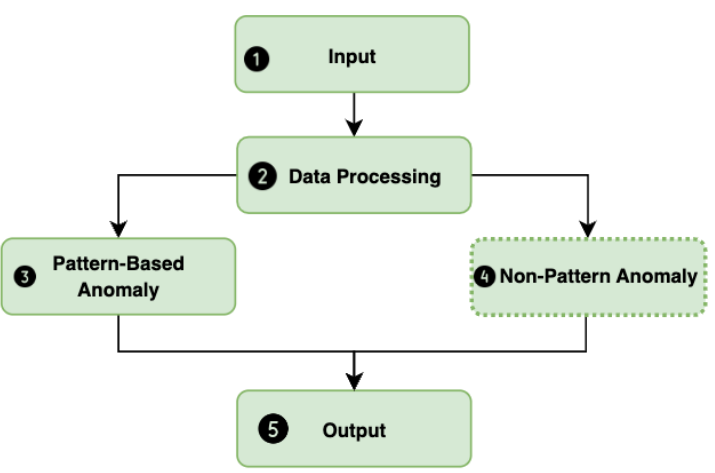
Figure 2. A high-level view of the proposed